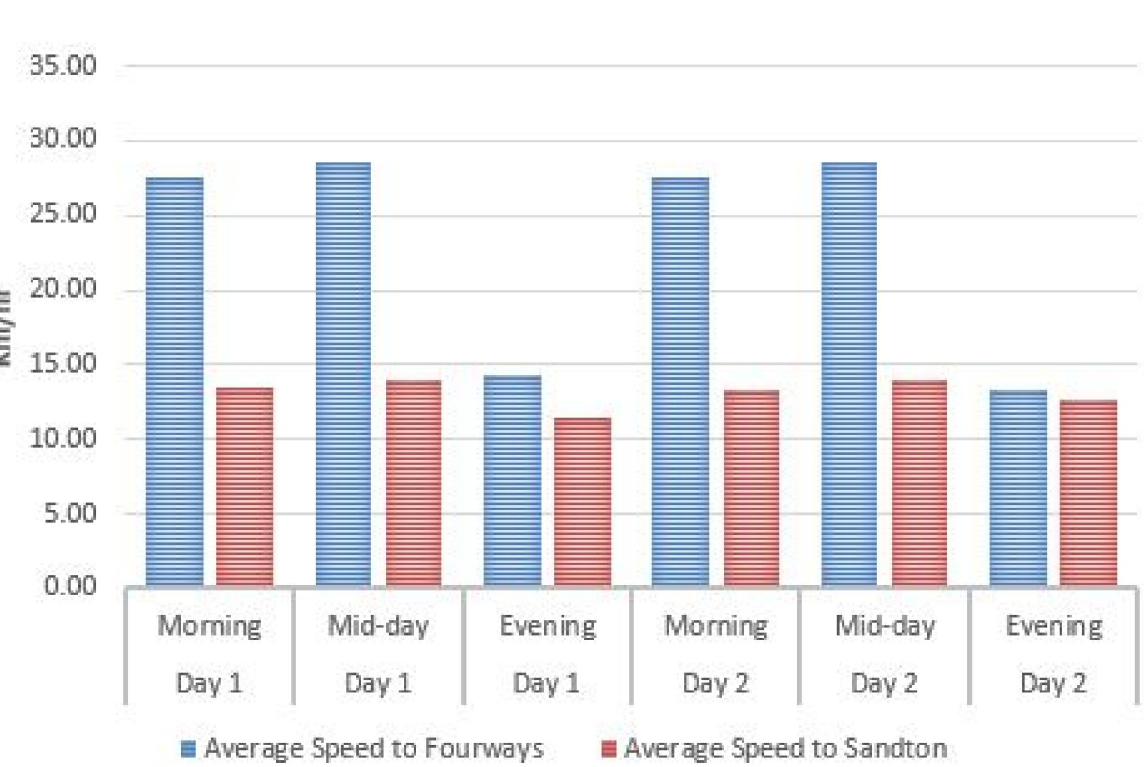
Fig 10. Average travel speed on the S5 Data Gaubus route near Sandton Gautrain station.